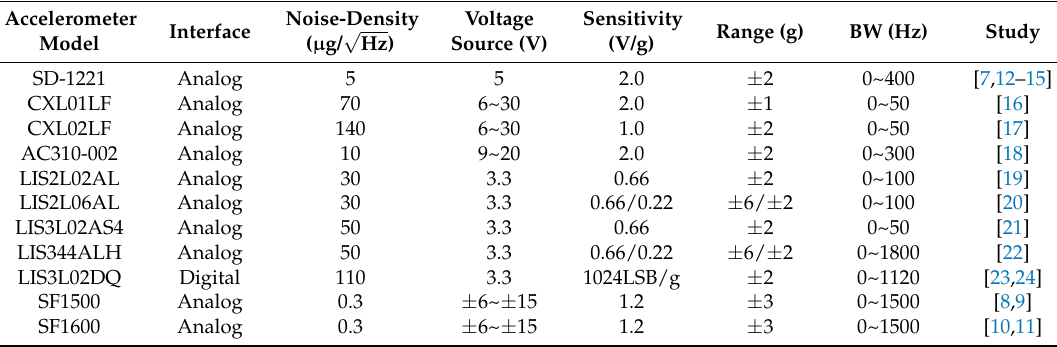
Table 1. Summary of MEMS-based accelerometers in WSS nodes.